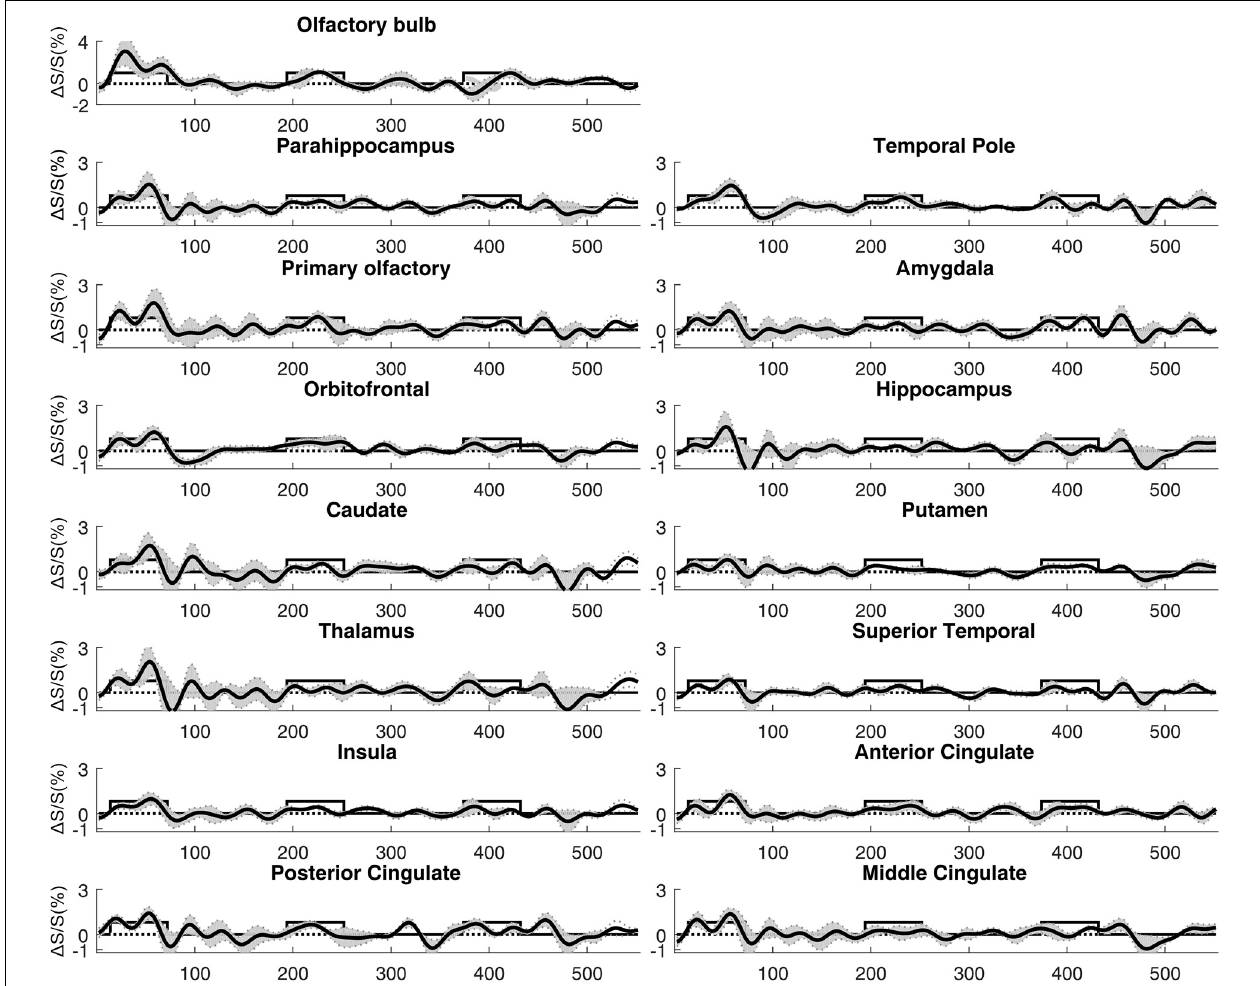
Figure 1 . The order of the ROIs was arranged to be identical to Figure 4 .